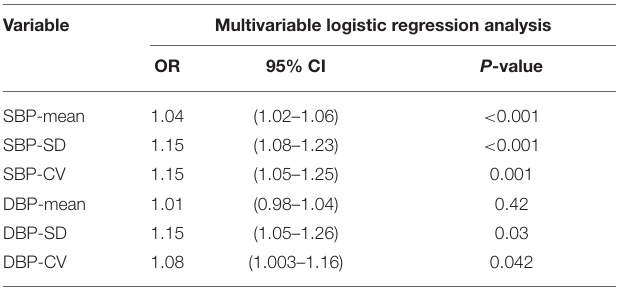
TABLE 4 | Multivariable logistic regression analysis of the unfavorable outcomes at 3 months. Variable